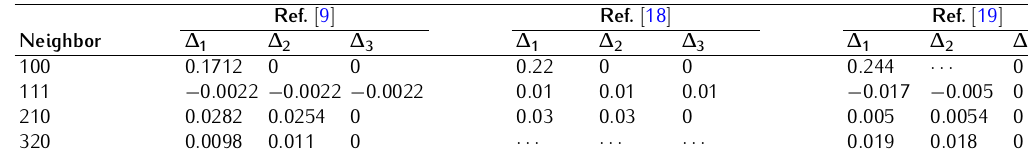
Table 4. The normalized displacement components of some selected neighbors of an OSIA within the Cu host lattice. (a) The results of the previous